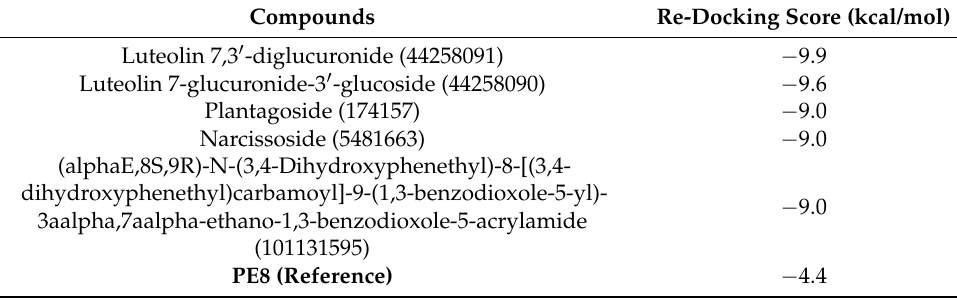
Figure 1. 2D structure of top five hits: ( a ) Luteolin 7,3 ′ -diglucuronide, ( b ) Luteolin 7-glucuronide-3 ′ - glucoside, ( c ) Plantagoside, ( d ) Narcissoside, ( e ) (alphaE,8S,9R)-N-(3,4-Dihydroxyphenethyl)-8- [(3,4-dihydroxyphenethyl)carbamoyl]-9-(1,3-benzodioxole-5-yl)-3aalpha,7aalpha-ethano-1,3- benzodioxole-5-acrylamide. Table 2. Re-docking score of top five hits selected from the virtual